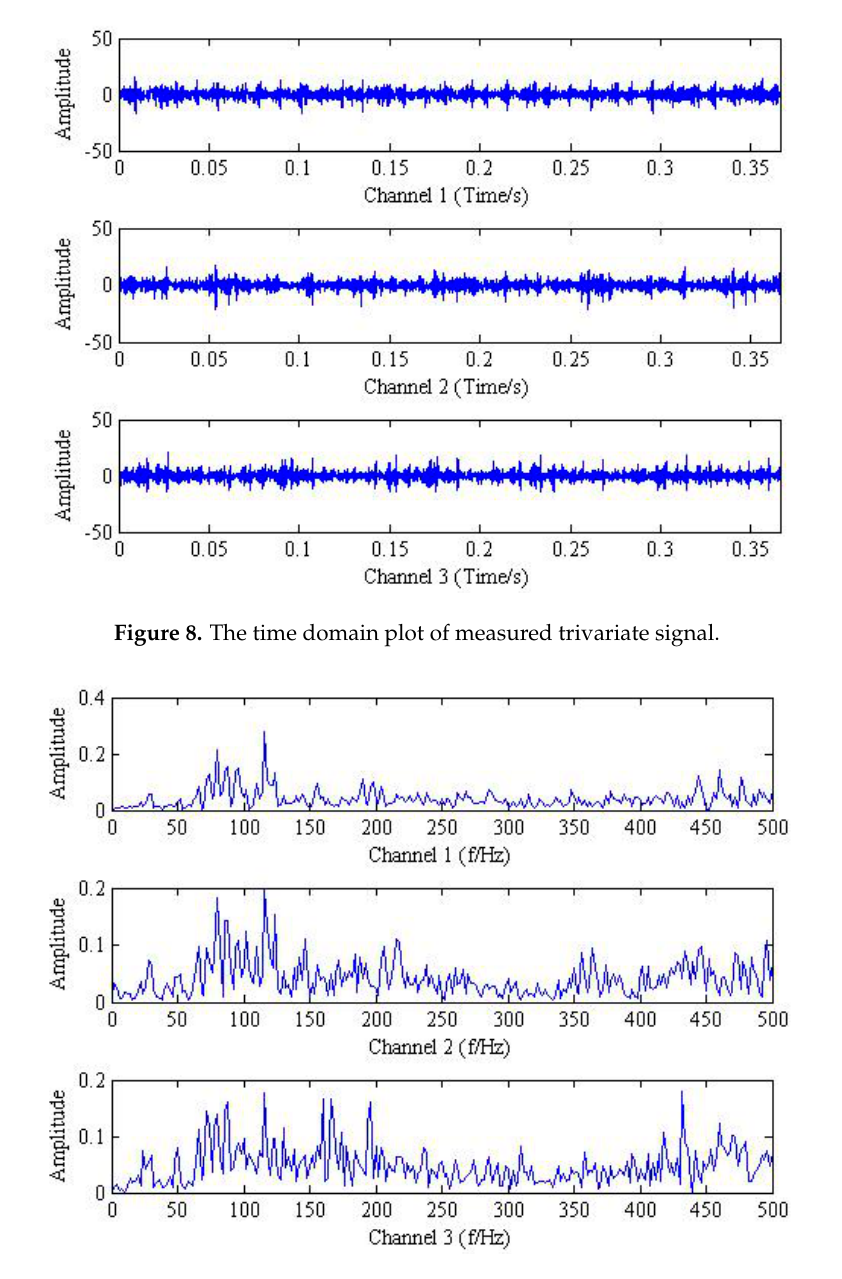
Figure 9. The frequency domain plot of measured trivariate signal.